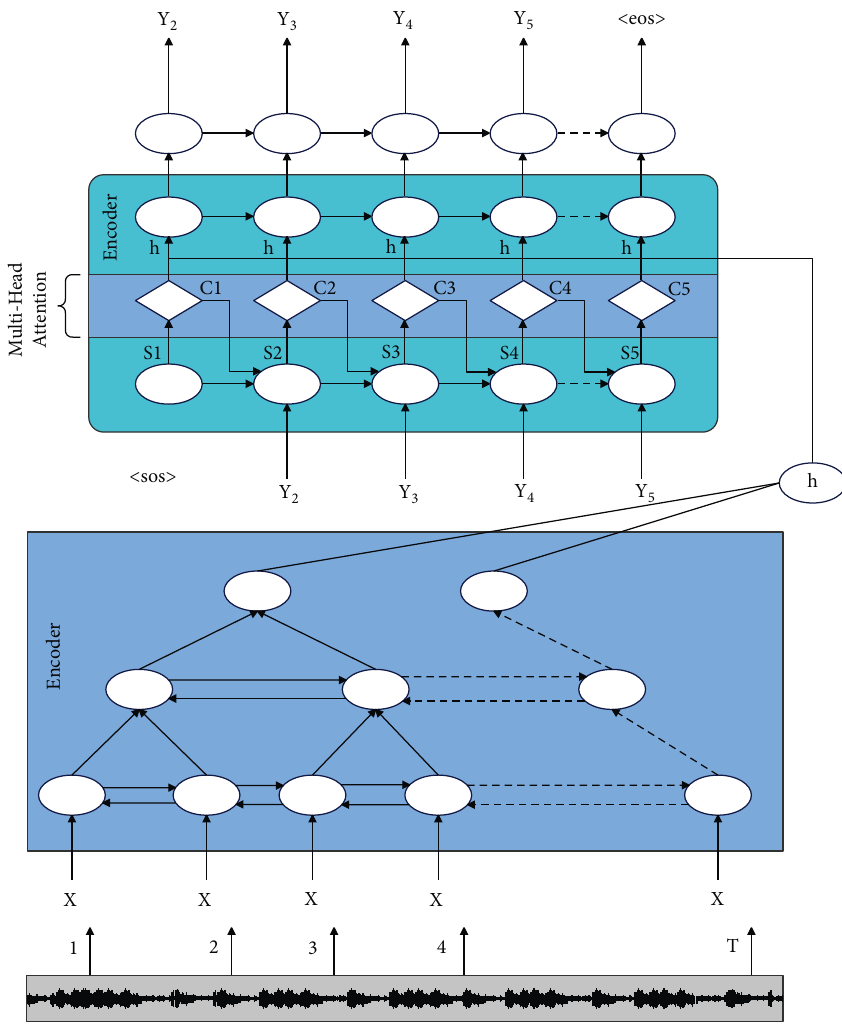
Figure 7: End-to-end model structure based on multihead attention